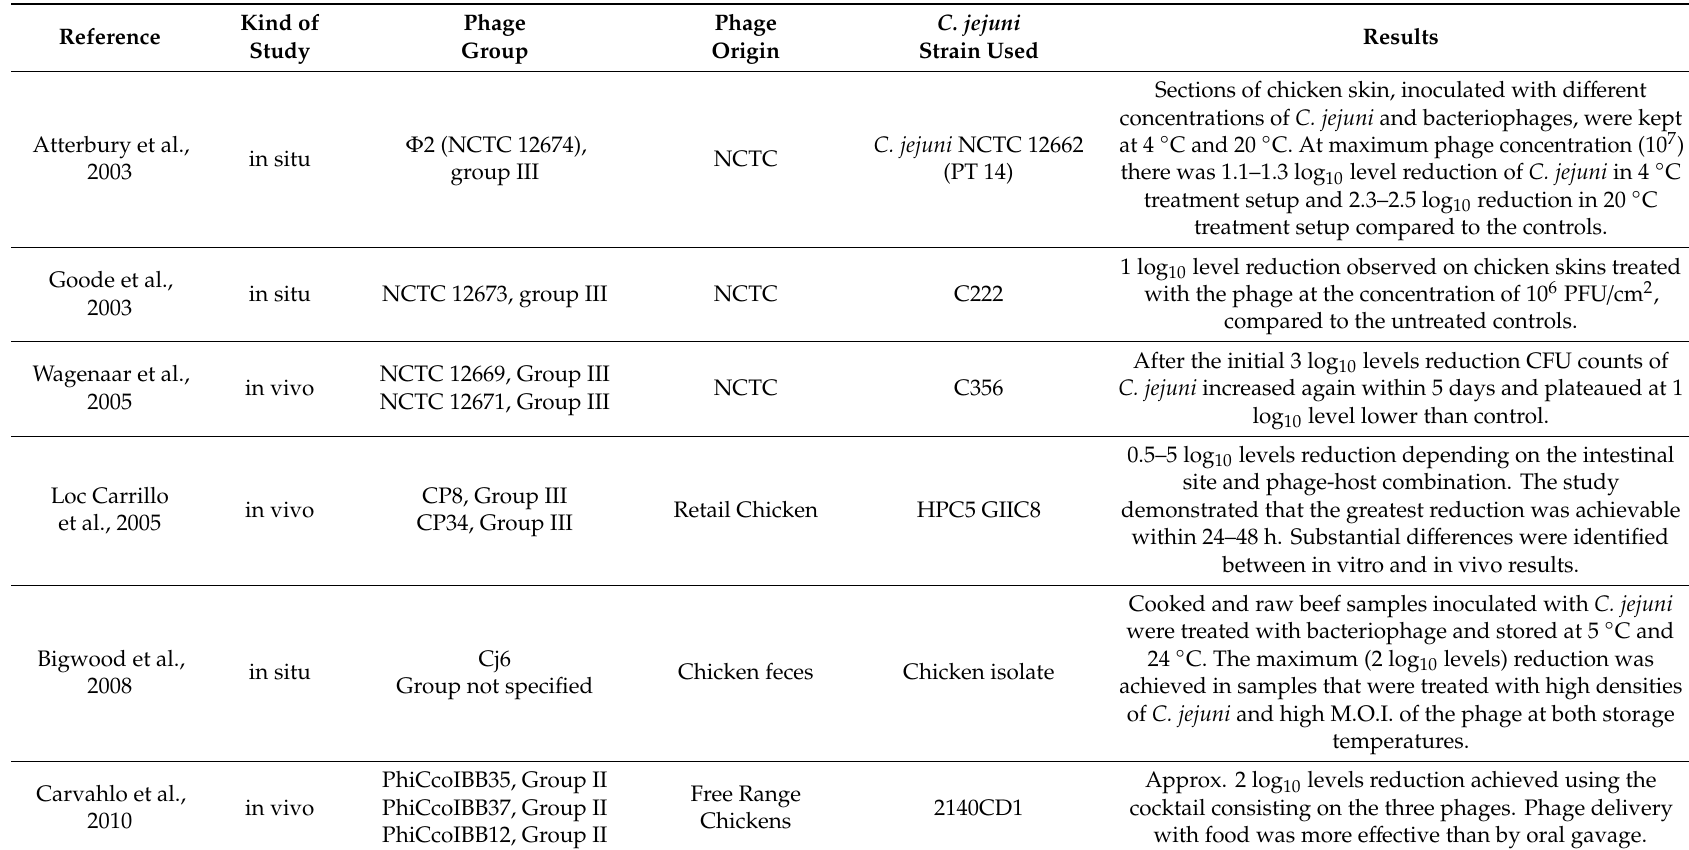
Table 2. Studies of C. jejuni -specific phages listed by